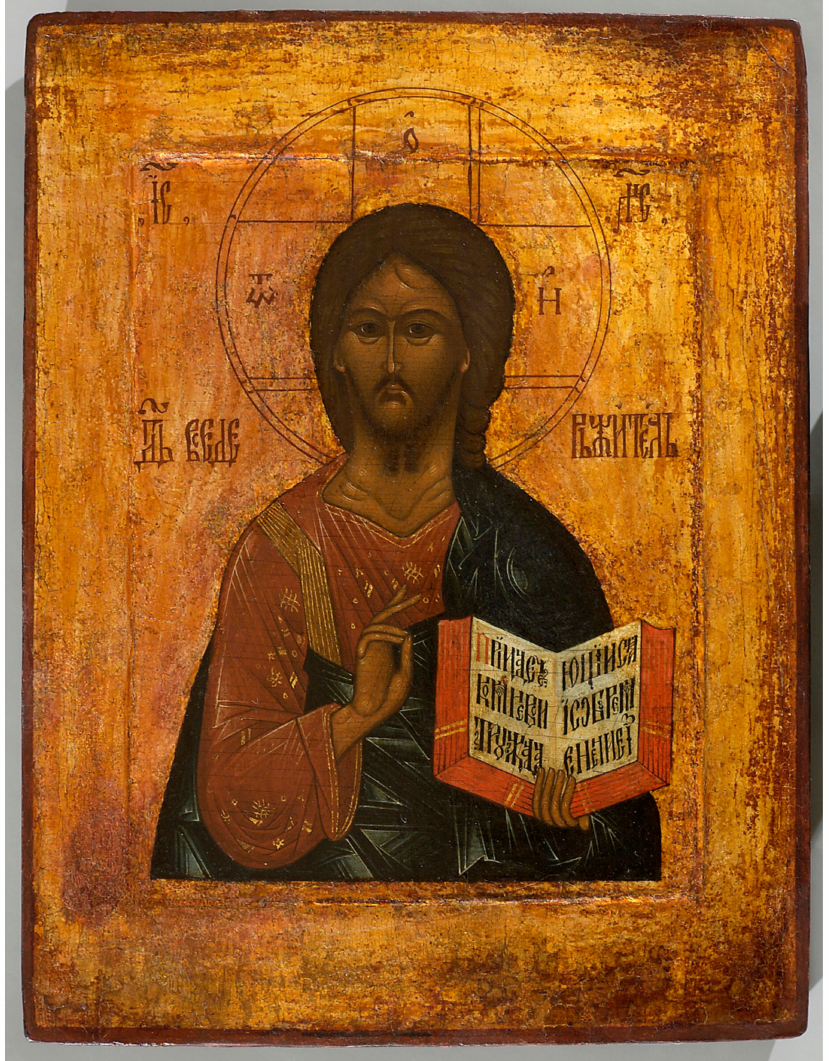
Figure 2. Christ Pantokrator, Russia, workshop of the Old Believers, end of 17th–beginning of 18th c., tempera on wood, 31 × 24 cm, National Museum in Warsaw, photo: National Museum in